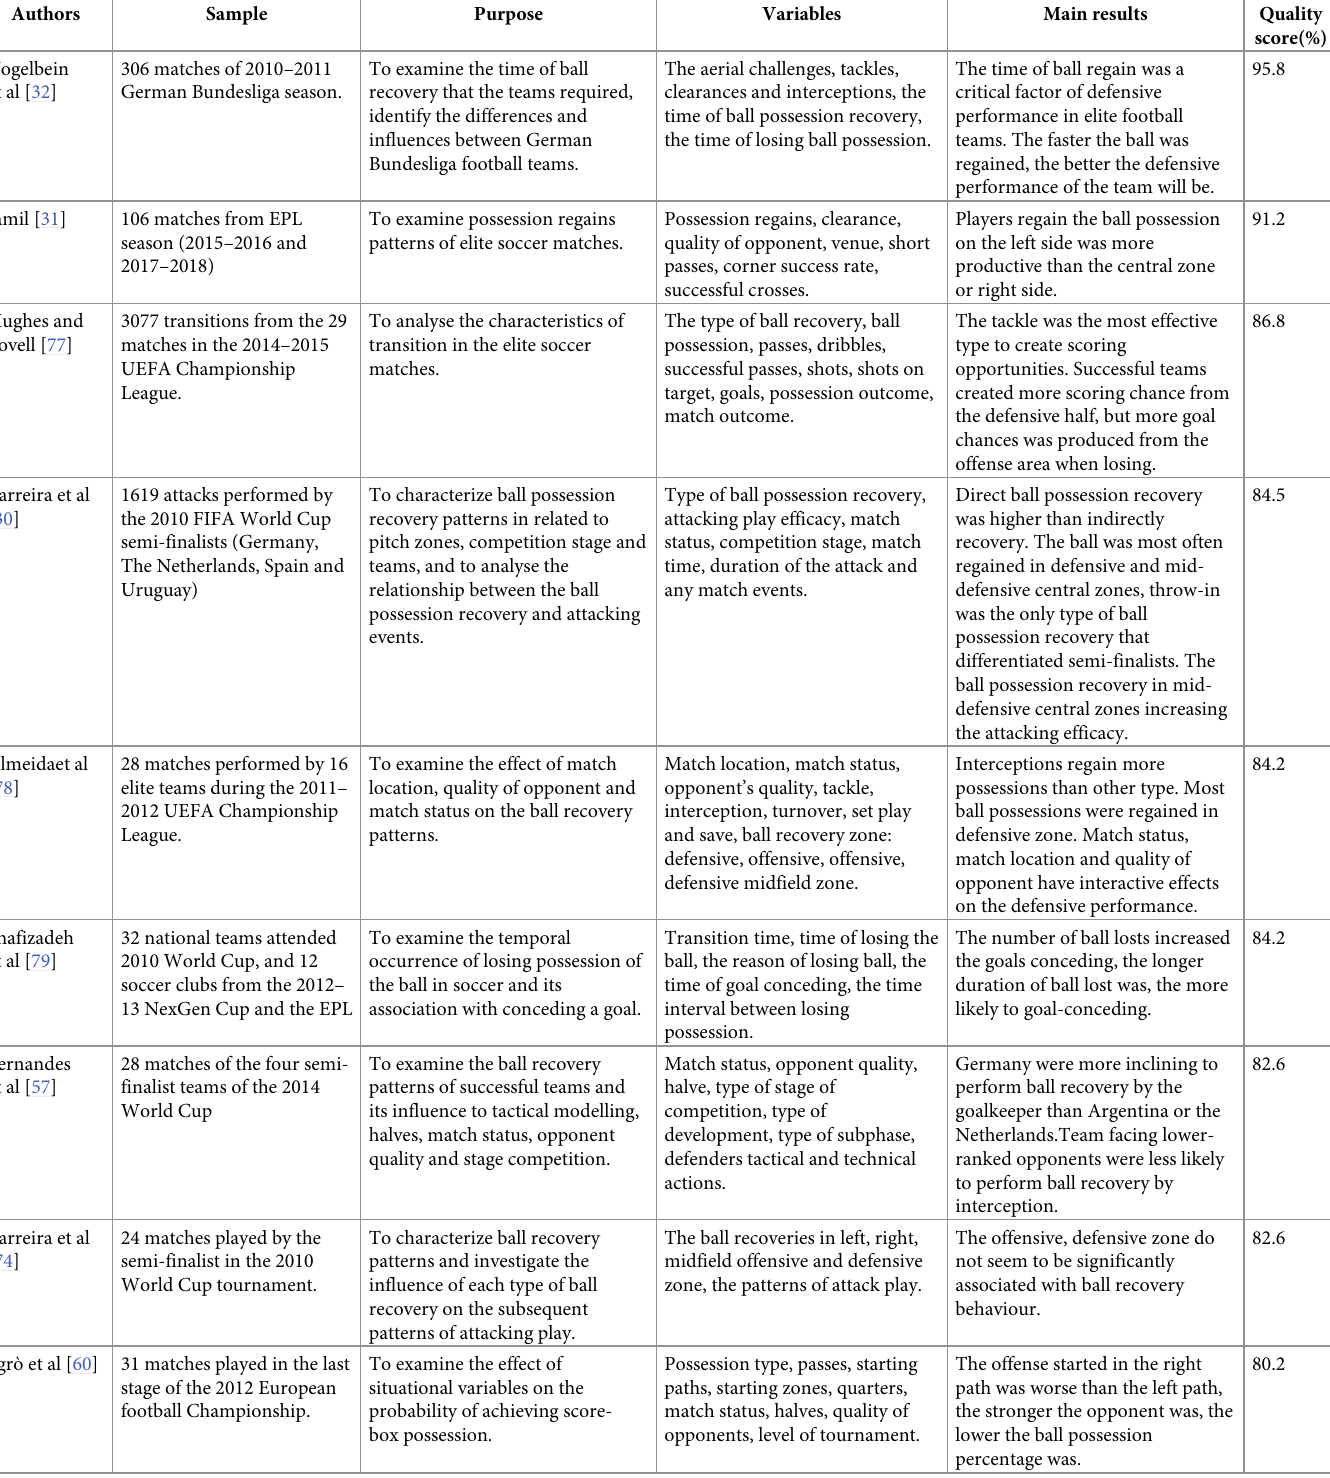
Table 4. Studies of the patterns of ball